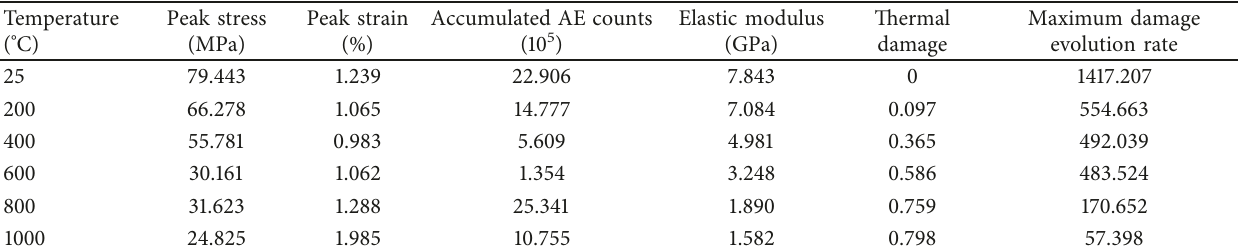
Table 1: Mechanical and damage values of granite at different